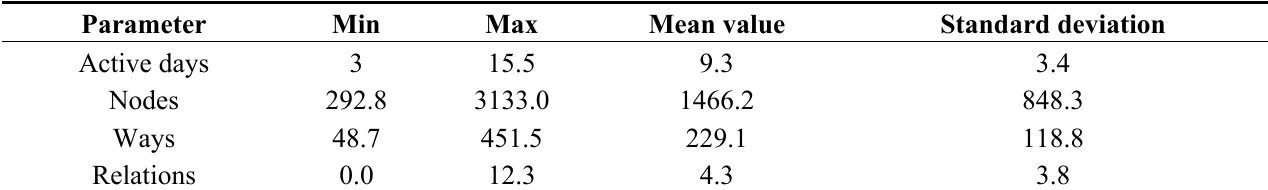
Table 2. Activity timeframe and contributions of a senior mapper (Aug.–Oct. 2012).